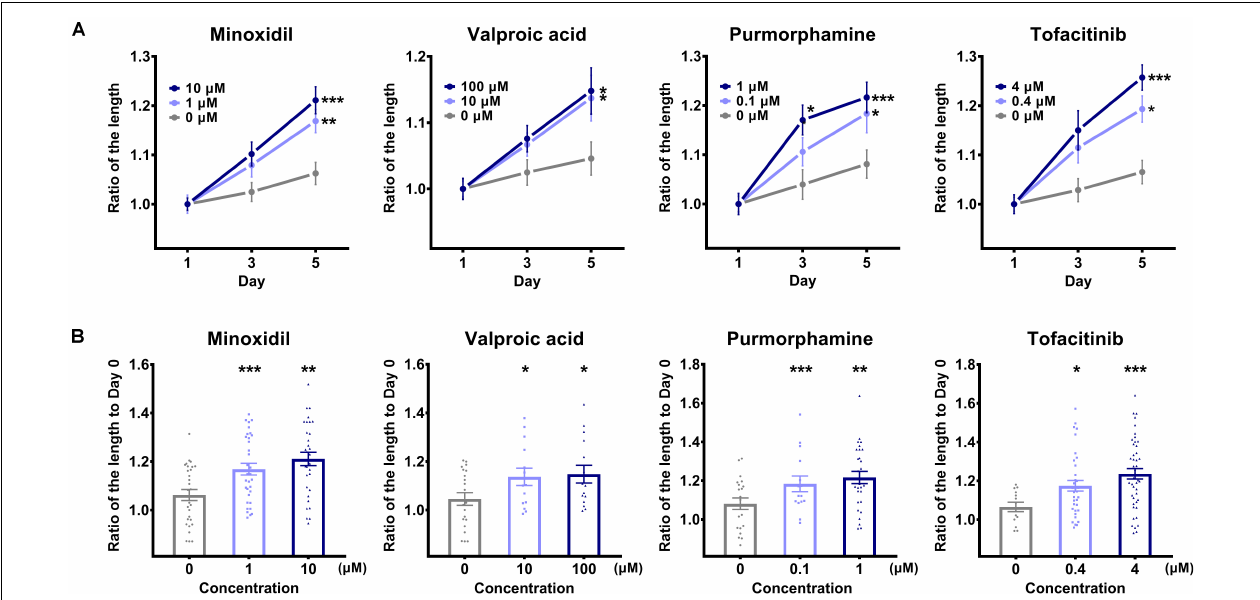
FIGURE 4 | Comparison of the long axis length of the “two-cell assemblage (TCA)” structure. (A) The long axis length of the TCA was compared after treatment with each molecule, with designated concentrations on the TCA structures, across three time points. Data are presented as mean ± SEM and were evaluated using one-way analysis of variance with Tukey’s multiple comparisons test. * p < 0.05, ** p < 0.01, or *** p < 0.001, compared to each control group on day 1. (B) The long axis length of the TCA was compared on day 5 among the different concentrations of each molecule. Data are presented as mean ± SEM and were evaluated using one-way analysis of variance with Tukey’s multiple comparisons test. * p < 0.05, ** p < 0.01, or *** p < 0.001, compared to each control group (0 µ M).